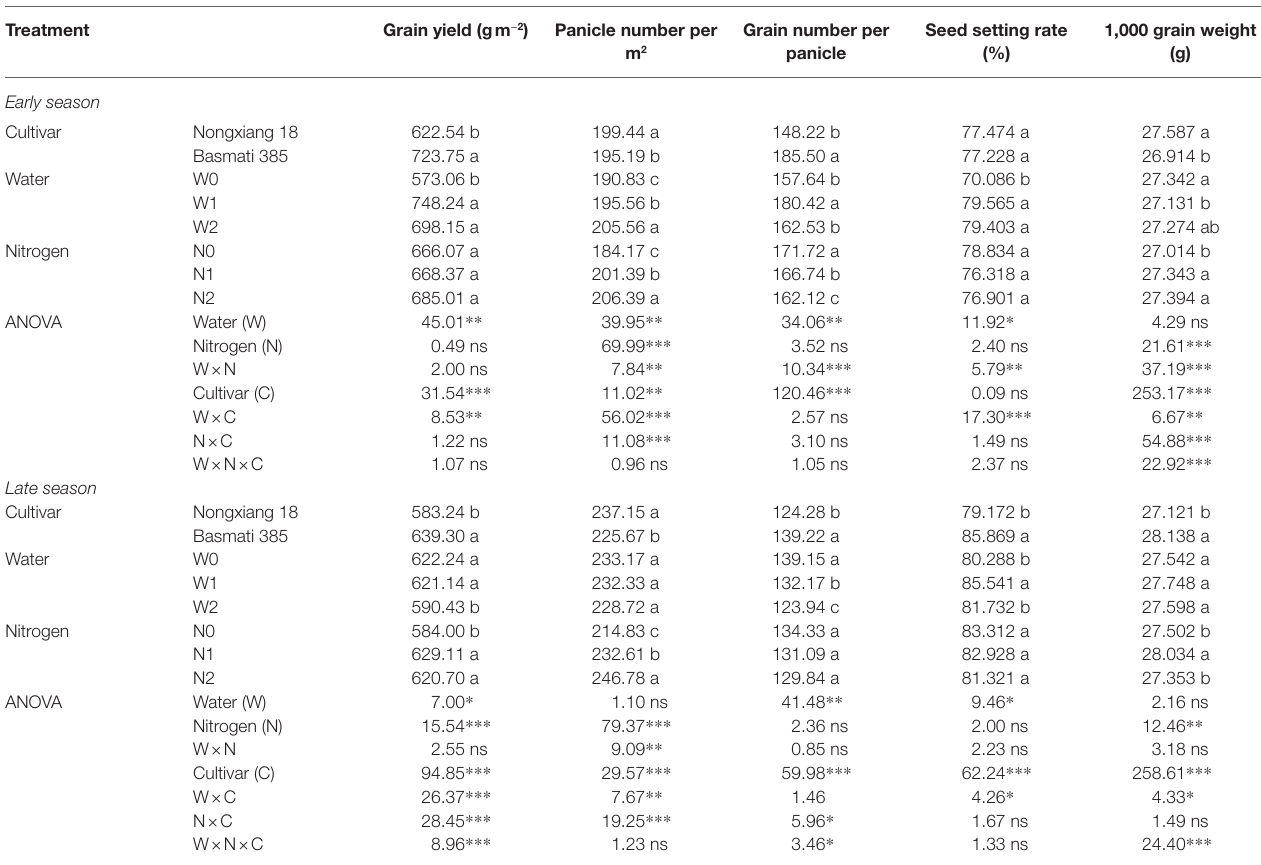
TABLE 3 | Grain yield and yield components as affected by water, nitrogen, and cultivars in the early and late seasons of double rice cropping system in South China.